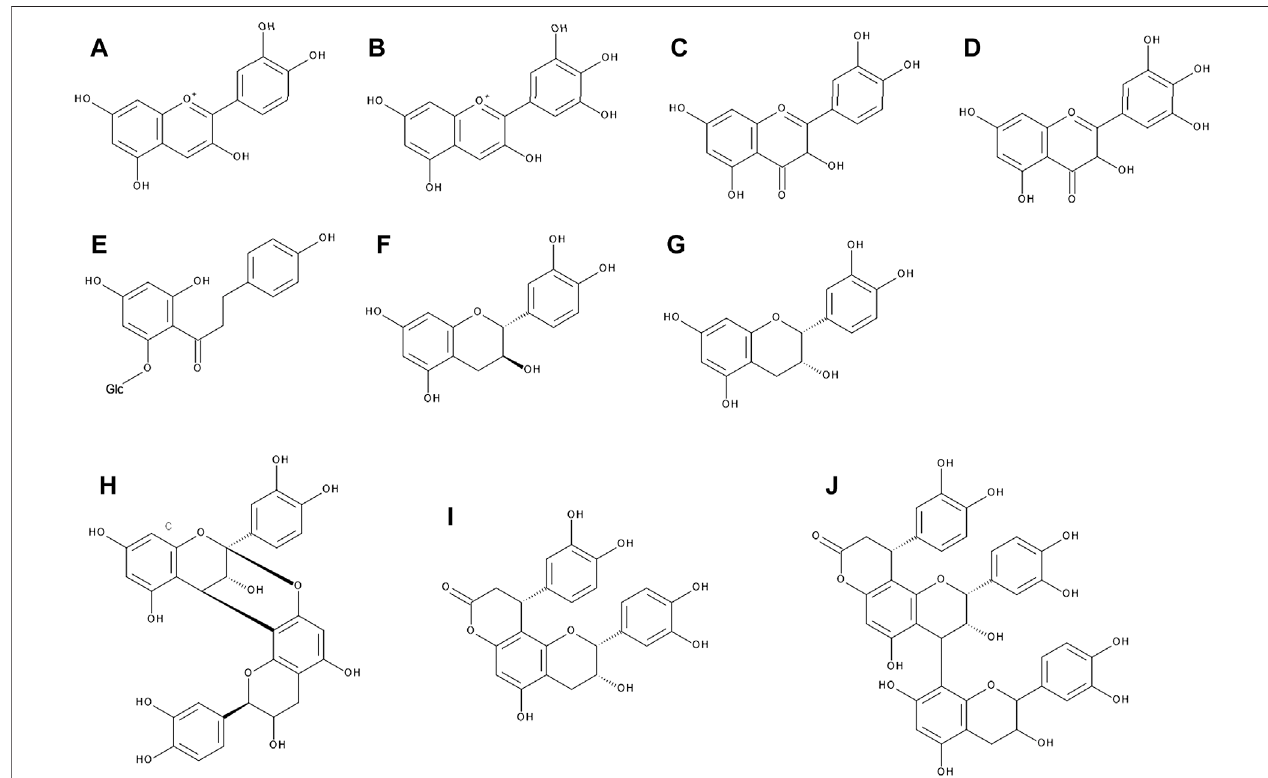
FIGURE 1 | The chemical structures of cyanidin (A) , delphinidin (B) , quercetin (C) , myricetin (D) , phlorizin (E) , catechin (F) , epicatechin (G) , A-type procyanidin dimer (H) , cinchonain Ia (I) , and cinchonain IIa (J) .